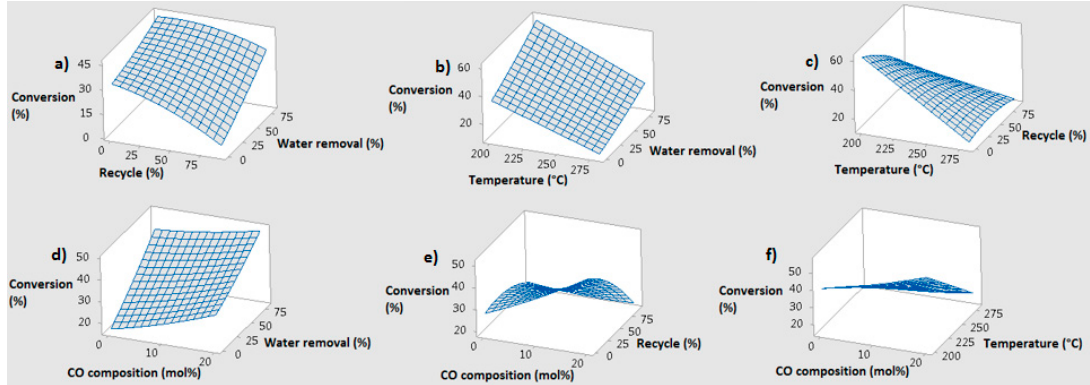
Figure 12. Carbon conversion plots as function of analyzed factors (hold values: recycle 45%, temperature 240 ◦ C, water removal 40%, CO composition in the feed 10 mol%): ( a ) carbon conversion as function of recycle and water removal; ( b ) carbon conversion as function of temperature and water removal; ( c ) carbon conversion as function of temperature and recycle; ( d ) carbon conversion as function of CO composition in the feed and water removal; ( e ) carbon conversion as function of CO composition in the feed and recycle; ( f ) carbon conversion as function of CO composition in the feed and temperature.